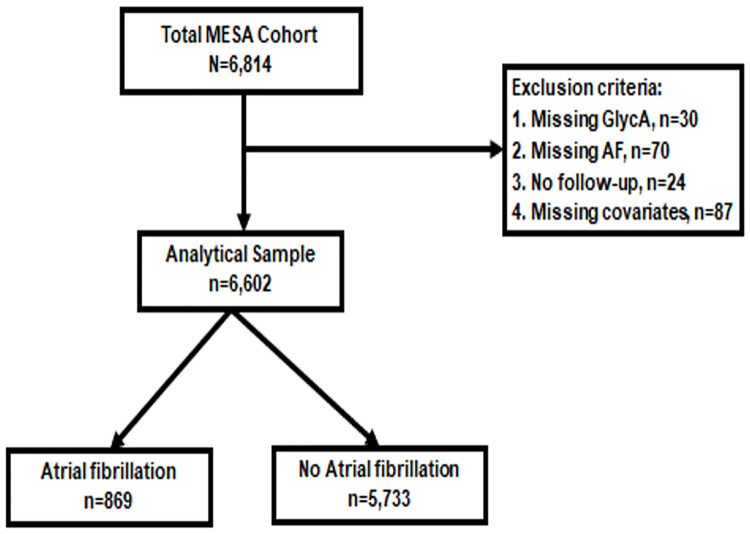
Flow diagram illustrating study sample inclusion and exclusion criteria as well as the number of participants with and without AF during follow-up.